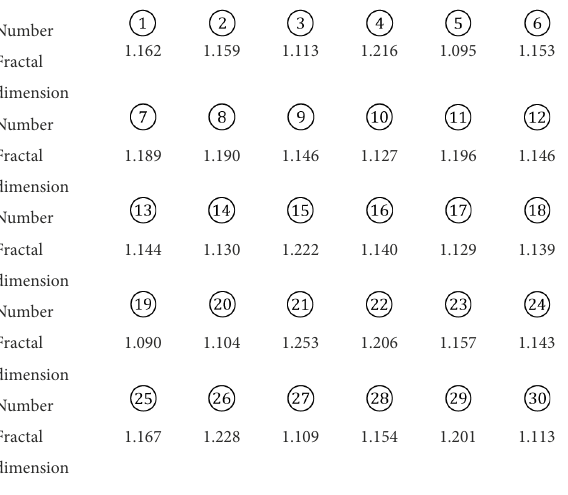
TABLE 3 Statistics of the fractal dimension of the water plane shape.